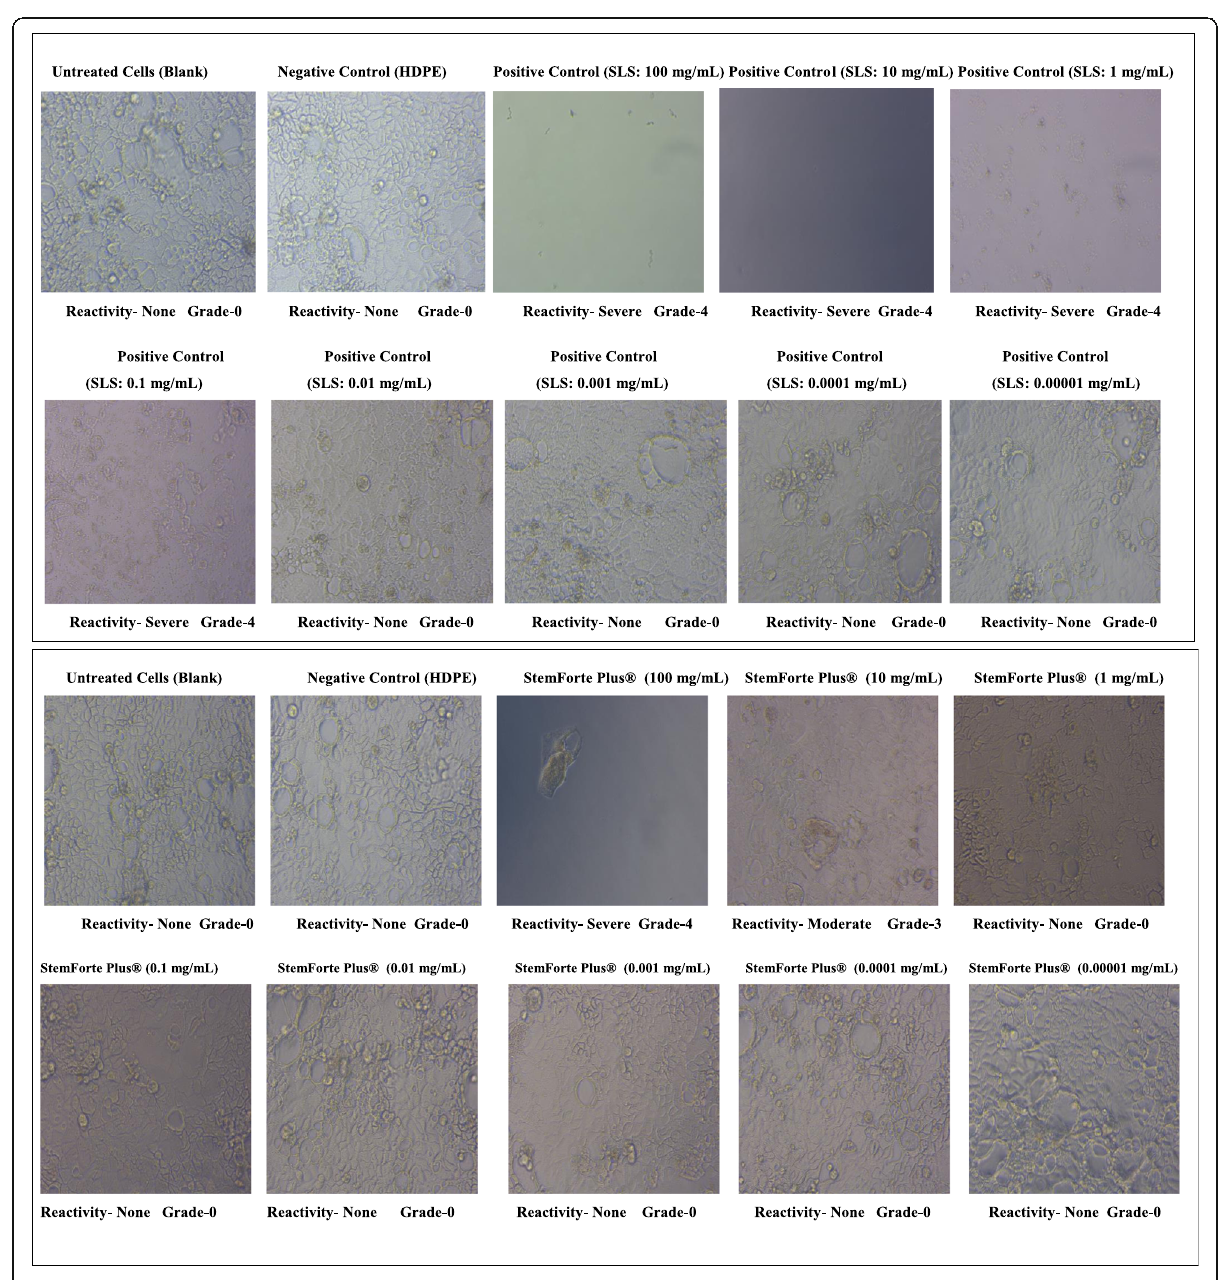
Fig. 1 Photographs of Caco-2 Cell Line treated with StemForte Plus® & Sodium Lauryl Sulphate